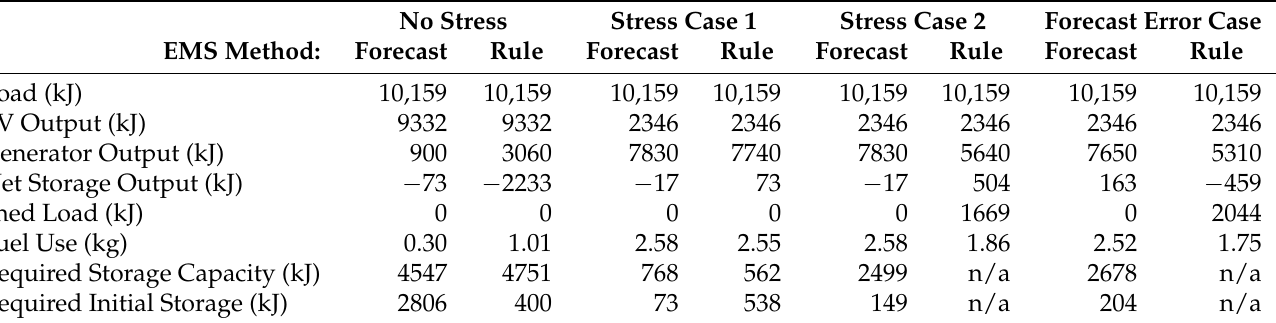
Table 2. Comparison of the forecast-based and rule-based EMS performance for the four scenarios described above. Note: the theoretical optimal fuel consumption for the No Stress case is 0.27 kg and 2.58 kg for all the other